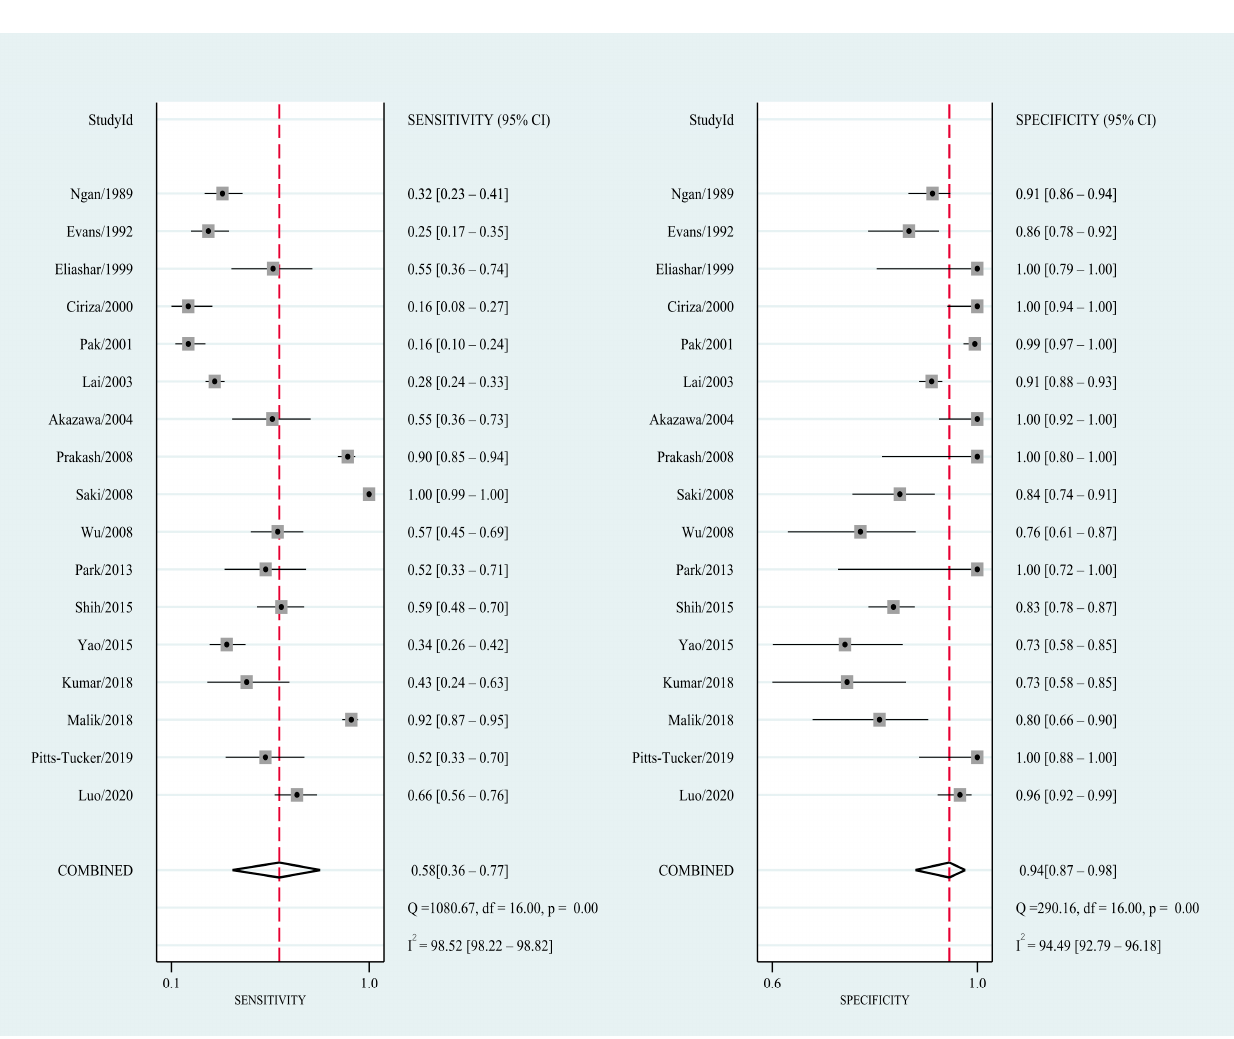
Figure 2. Forest plot of the sensitivity and specificity of conventional X-rays for the detection of foreign bodies in the upper digestive tract.